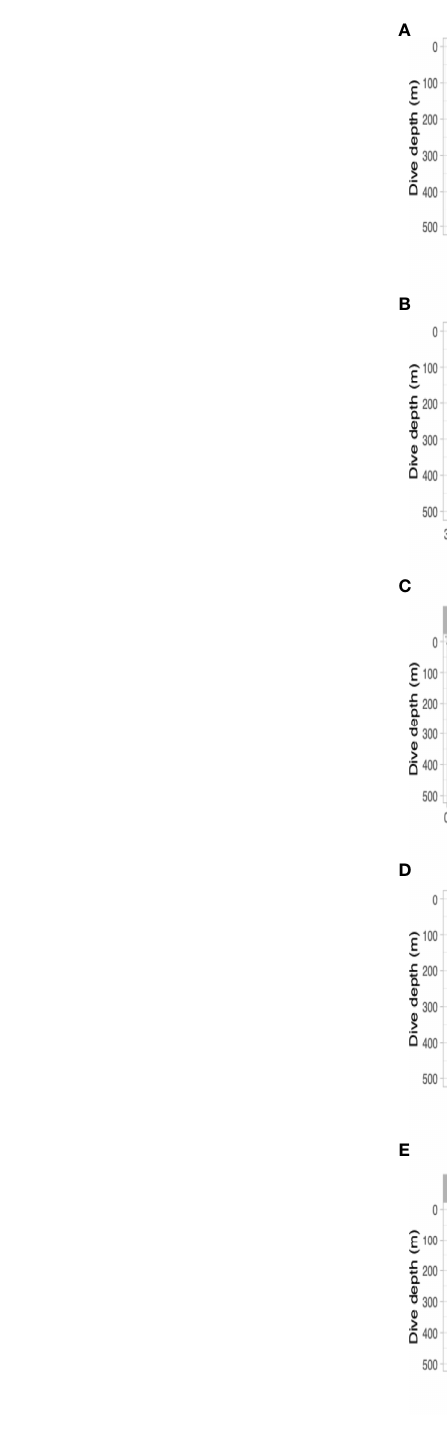
FIGURE 3 | Parameters of dive data recorded by the two whales tagged with SPLASH10-A dive reporting LIMPET tags. Dive activity is plotted by (A) dive depth versus date; (B) dive depth versus latitude; (C) dive depth versus sea fl oor depth; (D) dive depth versus dive duration and; (E) dive depth by time of day. In the scatter plots, blue circles are data from Oo36 and gray triangles are data from